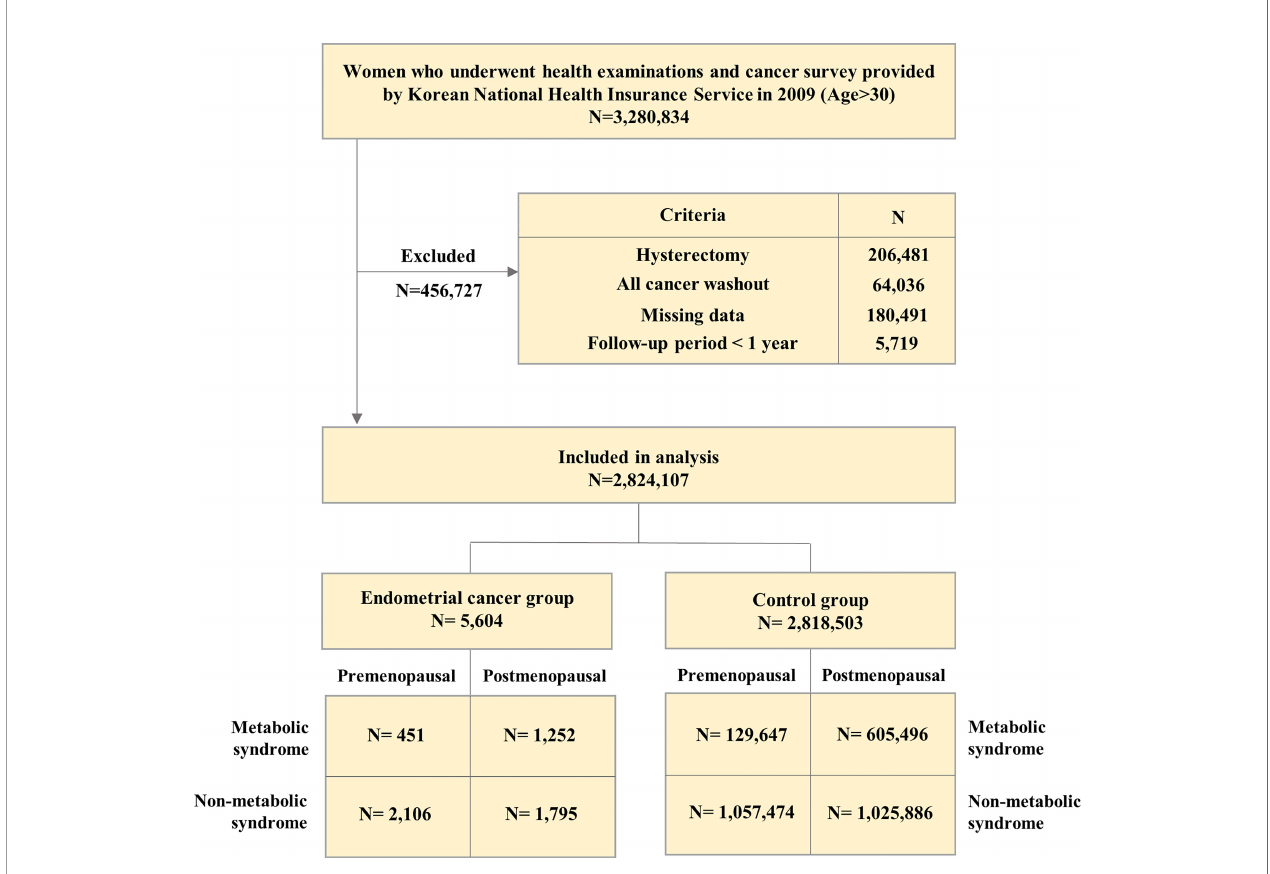
FIGURE 1 | Flow diagram of the search strategy and study